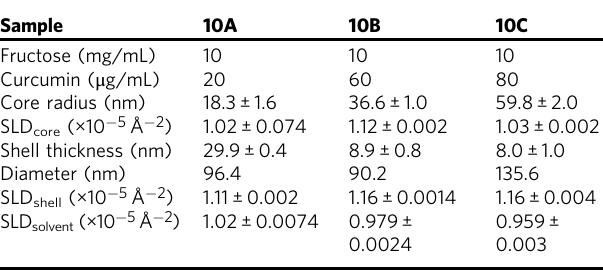
Table 1 SAXS data for samples at fi xed [Fru] = 10 mg/mL (10) and varying [CCM], where A = 20 µ g/mL, B = 60 µ